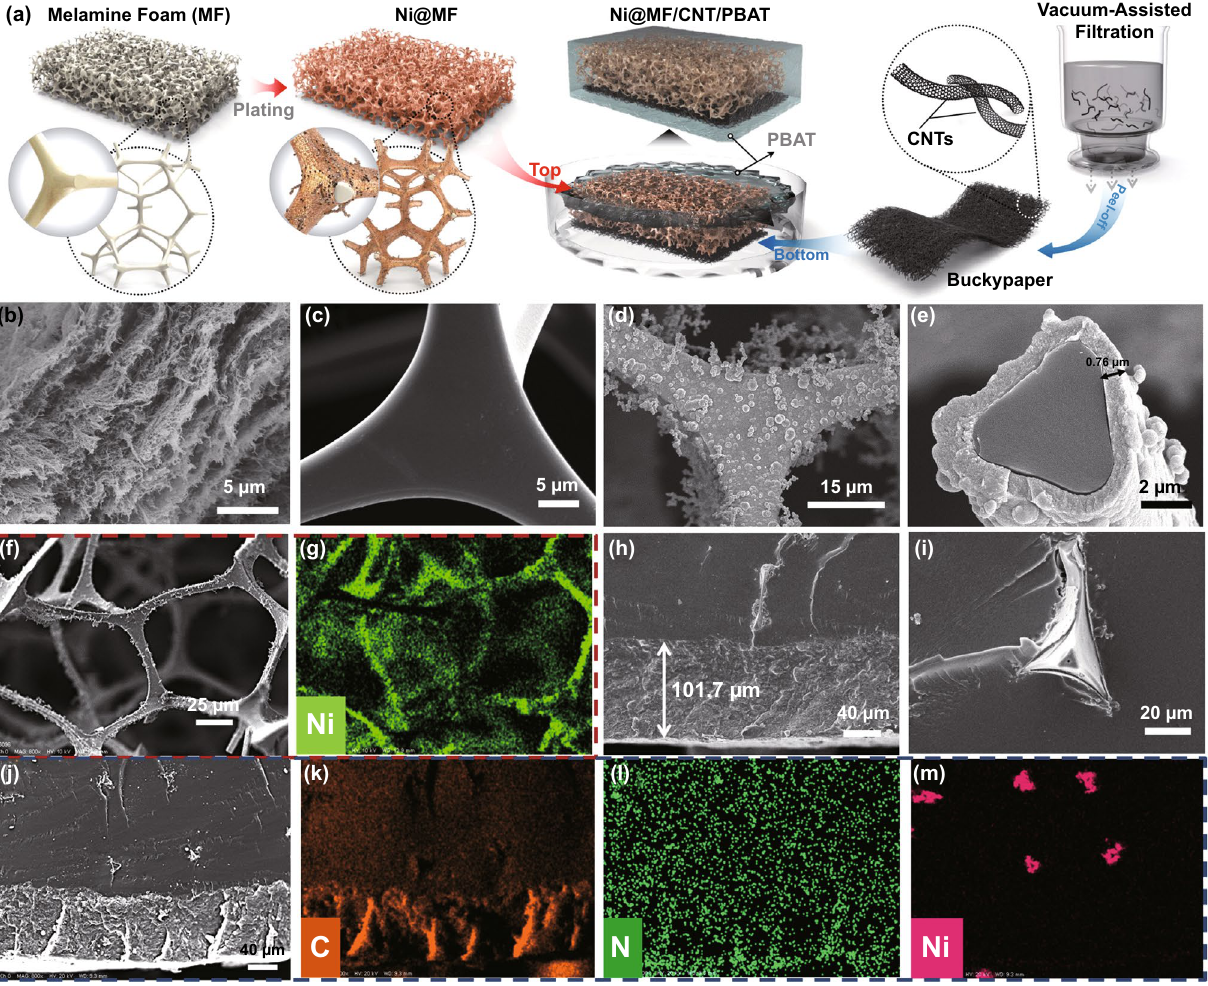
Fig. 1 Fabrication of step-wise asymmetric Ni@MF/CNT/PBAT composites. a Schematic diagram for the preparation process of step-wise asymmetric Ni@MF/CNT/PBAT composites. b and c SEM images of CNT paper and pure MF sponge, respectively. d and e SEM images of Ni@MF-5 at different magnifications, where 5 represents the Ni-plating time of 5 min. f and g SEM of Ni@MF-5 with Ni elemental EDS map- ping. h SEM image of the lower CNT-75/PBAT layer in Ni@MF-5/CNT-75/PBAT, where 75 denotes the thickness of CNT paper (μm). i SEM image of the upper Ni@MF-5/PBAT layer. j‑m SEM of Ni@MF-5/CNT-75/PBAT with C, N, Ni elemental EDS